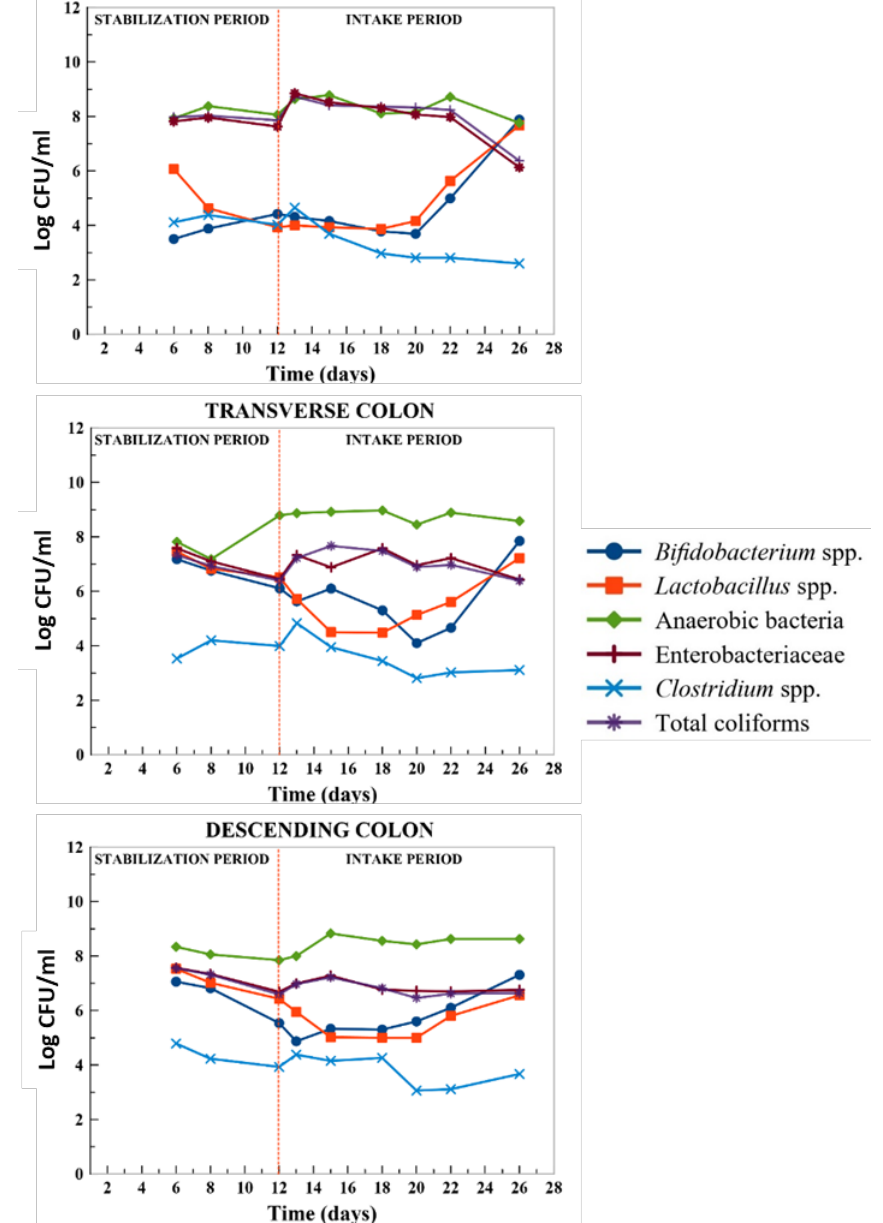
Figure 5. Changes in bacterial populations in the AC (ascending colon), TC (transverse colon), and DC (descending colon) during the stabilization period and intake period with HPP-treated onion: days 0 (13), day 2 (15), day 5 (18), day 7 (20), day 9 (22), and day 13 (26). Results are expressed as log CFU/mL ( n = 2).